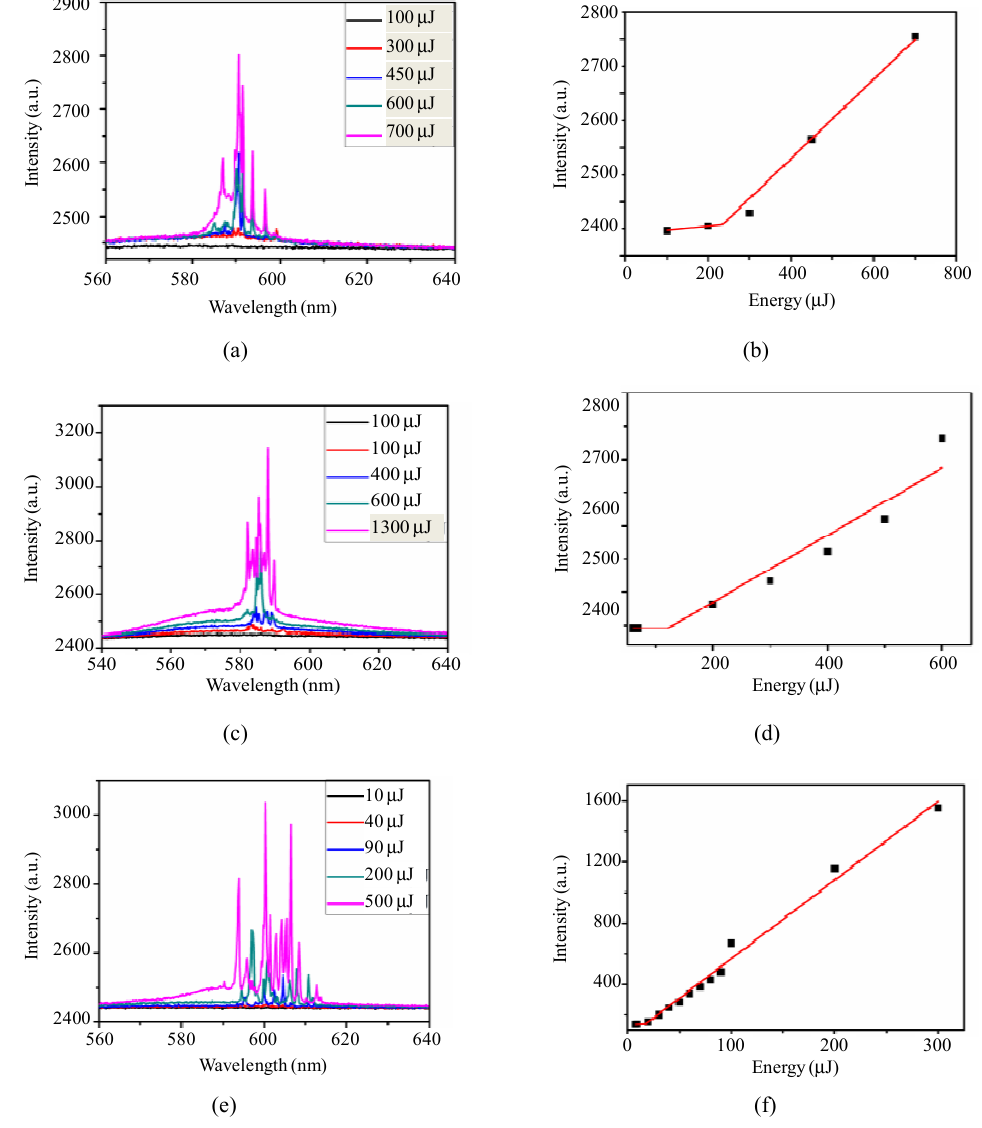
Fig. 4 Random lasing spectra at different energy pumps for (a) 0.156 wt.%, (c) 0.234 wt.%, and (e) 0.312 wt.% dye doped vesicles; and the input-output relation corresponding to the above (b–f)